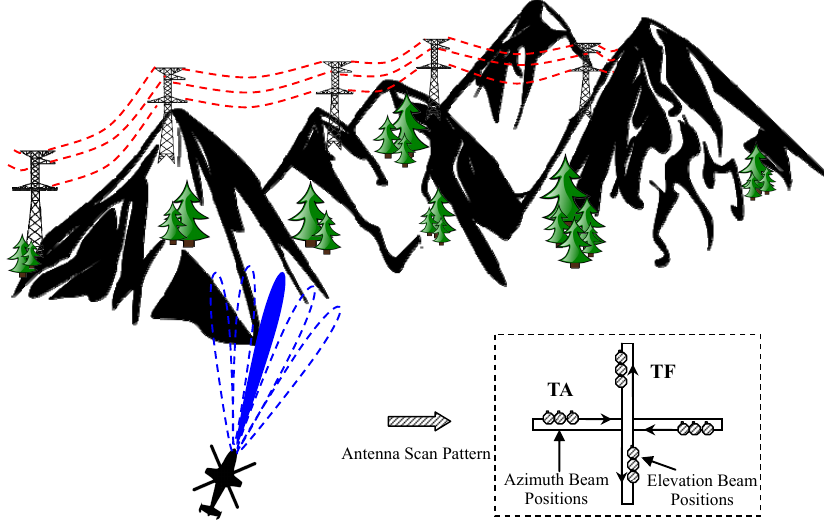
Figure 1. Target detection model of a low-flying